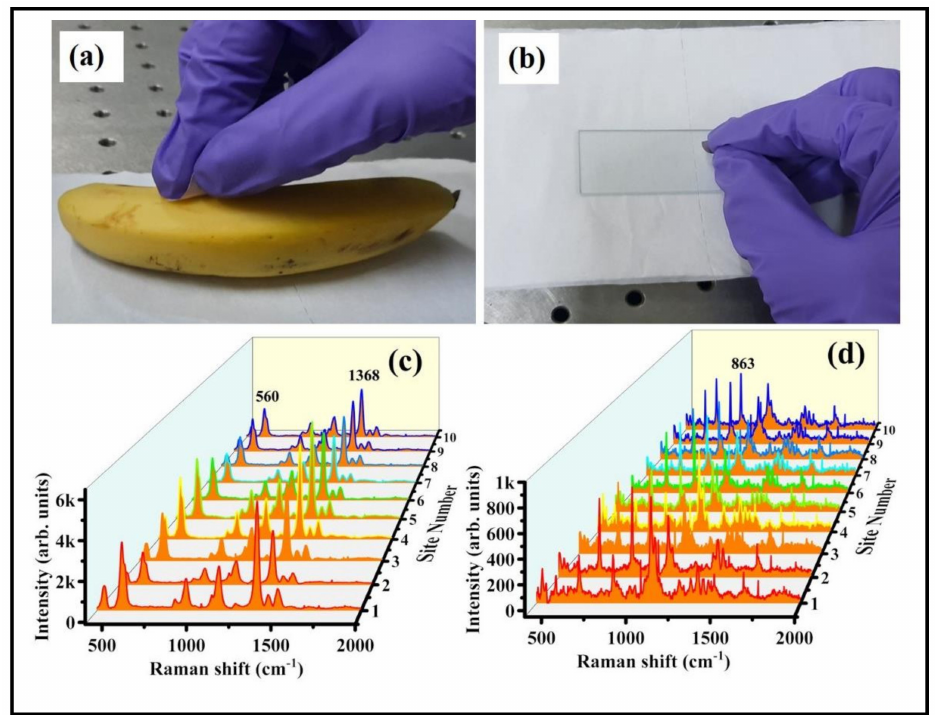
Figure 9. ( a , b ) Photograph of thiram and RDX collection by simple swabbing on banana and glass surfaces using flexible FP substrate. ( c ) Thiram SERS spectra were recorded by swabbing on a banana ( d ) RDX SERS spectra recorded by swabbing on glass and collected the data from randomly selected 10 sites on optimized FPAu SERS substrate (after